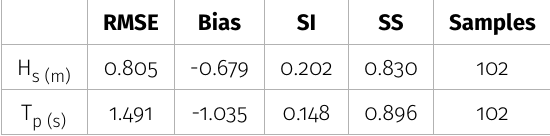
Table IV. Statistical parameters for extreme event analysis: Buoy x Model. RMSE Bias SI SS Samples H 0.805 -0.679 0.202 0.830 102 s (m) T 1.491 -1.035 0.148 0.896 p (s)